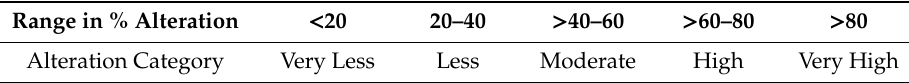
Table 10. Range for alteration categories